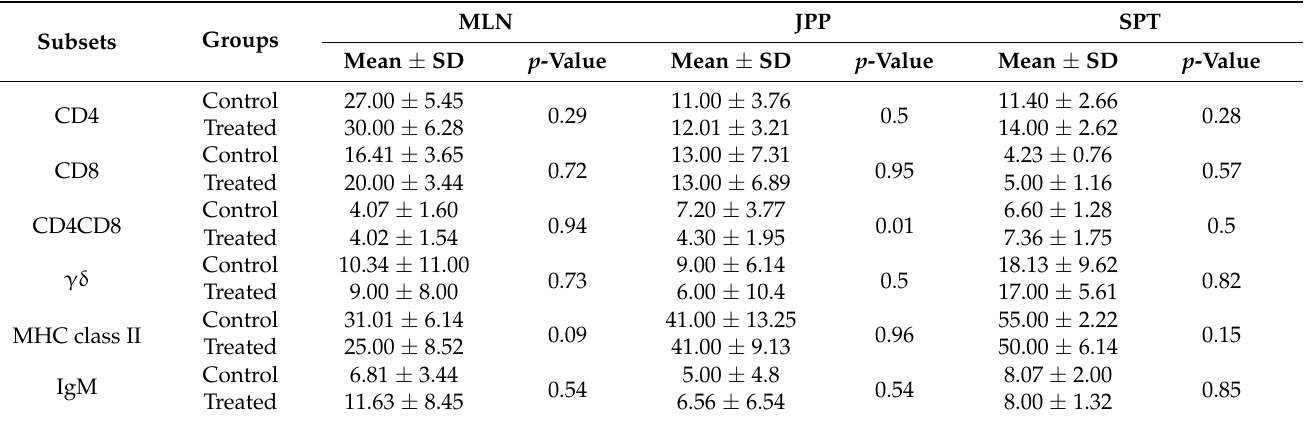
Table 1. Relative population of T cells and B cells in secondary lymphoid organs of BT treated and control groups.